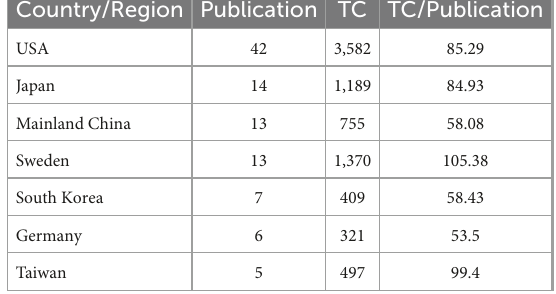
TABLE 3 Number of publication and total citation by